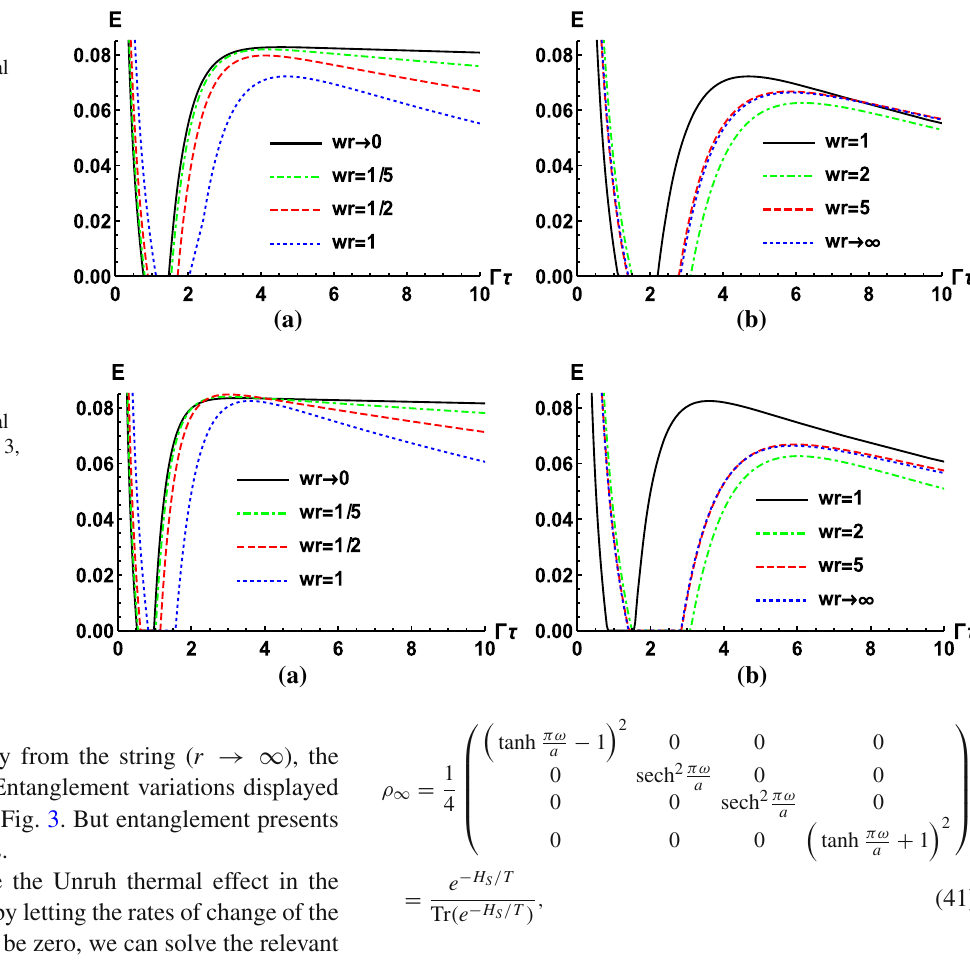
Fig. 3 Entanglement as function of Γ τ with different atom-string distances for initial Werner state with p = 2/3, ν = 2, a /ω = 1 / 2 and ω L = 1 / 2